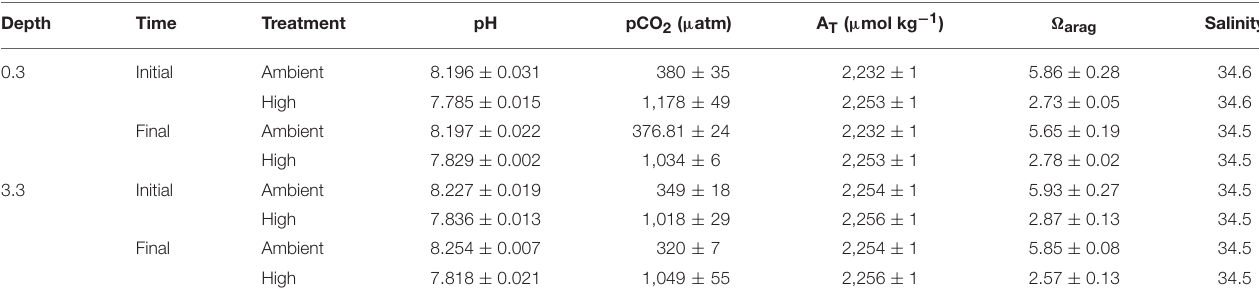
TABLE 1 | Mean carbonate chemistry parameters (mean ± SE, n = 3–4) in sealed vertical tubes in Okinawa, initially and after a 24h incubation in ambient or high pCO 2 , for trials at 0.3-m MD and 3.3-m MD.